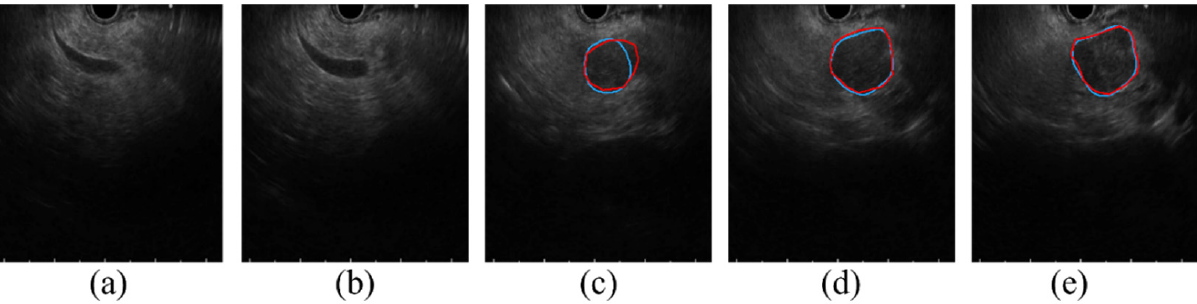
Figure 8. Consecutive EUS images in 0.5 s intervals from a recorded EUS video. ( a , b ) show common bile duct with no visible cancerous region, ( c – e ) show pancreatic cancer precisely segmented using DAF-Net (Red line: GT boundary, blue line: predicted boundary).